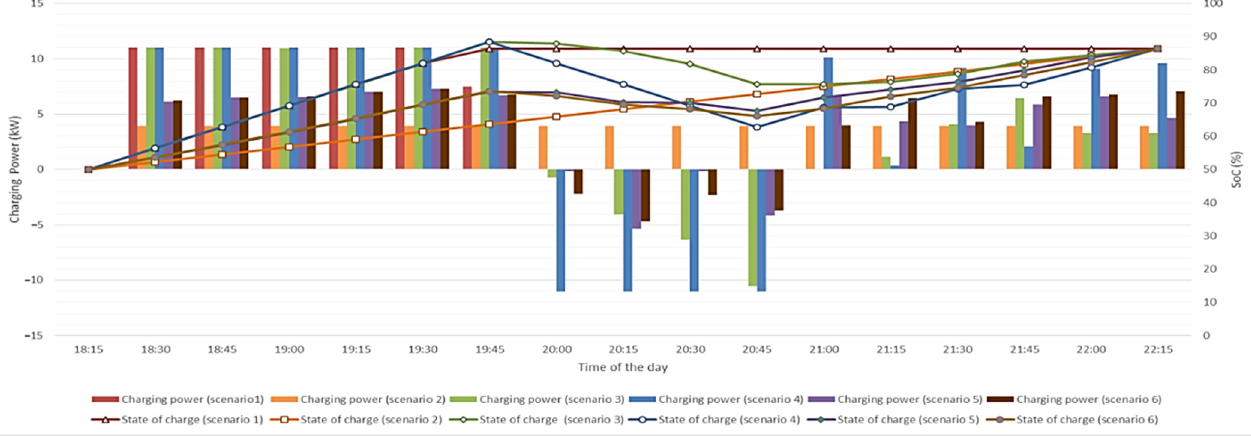
Figure 16. SoC and charging power trajectories for the 702nd EV (EV CS = 386) being plugged into an AC charger (3-phase 16A).